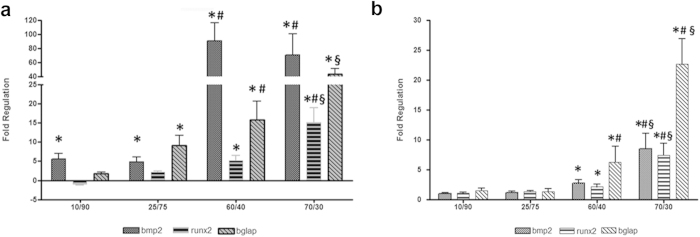
Changes in bmp2, runx2 and osteocalcin (bglap) mRNA expression in PDPCs seeded on (a) Gel and (b) HA/Gel scaffolds. Data are expressed as fold-regulation which represents fold-change results in a biologically expressive manner. Fold-regulation is equal to the fold-change (2−ΔΔCt) for fold-change values greater than one, which indicate an up-regulation. Fold-change values less than one indicate a down-regulation: in this case the fold-regulation is the negative inverse of the fold-change (−1/2−ΔΔCt). a = p < 0.05 vs CTRL; b = p < 0.05 vs 25/75 scaffolds; c = p < 0.05 vs 60/40 scaffolds.